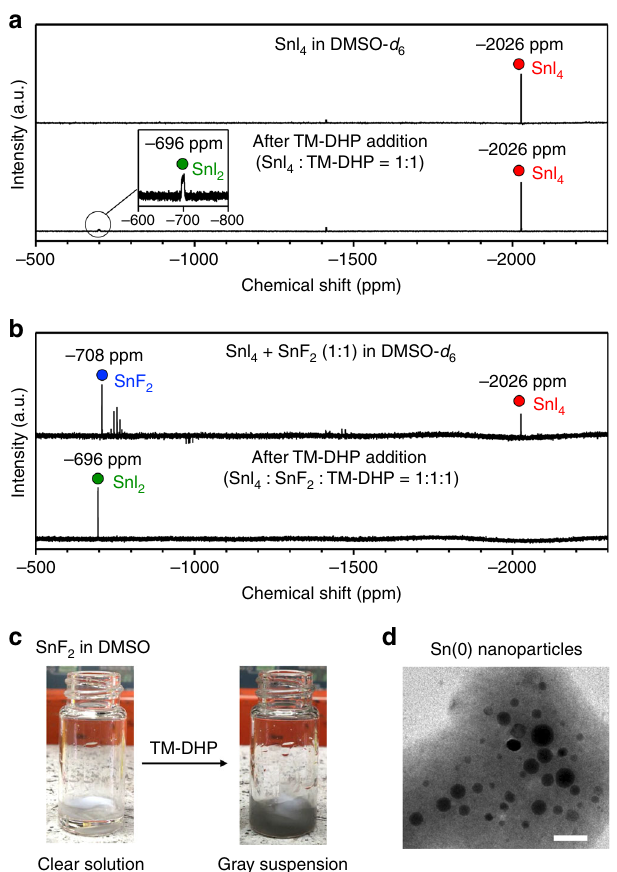
Fig. 3 Elucidation of the Sn(IV) scavenging mechanism. 119 Sn NMR spectra of a SnI 4 , and b SnI 4 with SnF 2 in DMSO- d 6 , before (top) and after (bottom) adding 1 equivalent of TM-DHP. c Photos of the SnF 2 solution before (left) and after (right) the addition of TM-DHP and d TEM image of the formed Sn nanoparticles. The scale bar is 20